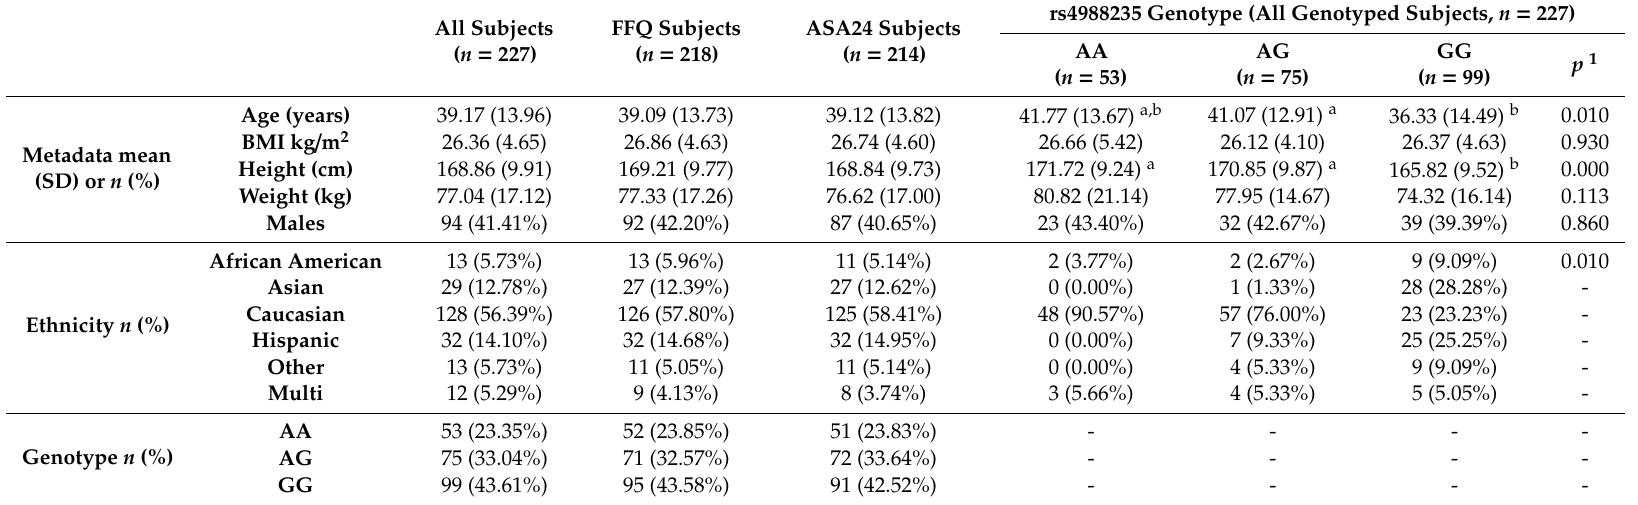
Table 1. Characteristics for all study subjects, as well as for each genotype, and subjects included for FFQ and ASA24